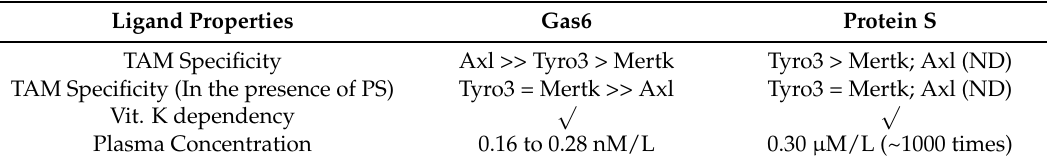
Table 1. Properties of TAM